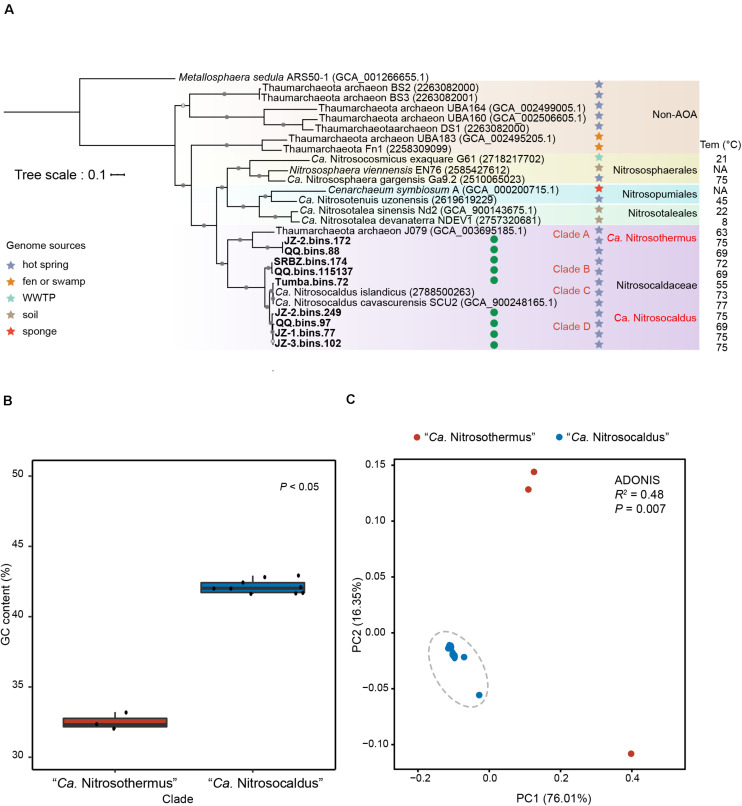
(A) Phylogenetic tree of Thaumarchaeota based on concatenation of 122 archaeal marker genes with Metallosphaera sedula ARS50-1 as outgroup (only a few genomes of other Thaumarchaeota are shown). MAGs newly obtained in this study are marked with green circles. Sources of Group HWCG-III MAGs are indicated by stars with different colors. The temperature values refer to temperature measured in the source materials. Nodes with ultrafast bootstrap value ≥95% (50%) are indicated as solid (hollow) circles, and the scale bar at the top indicates 10% sequence divergence. (B) Genome G+C content of Clade A (“Ca. Nitrosothermus”) vs. Clades B, C, and D (“Ca. Nitrosocaldus”). (C) Principal coordinates analysis (PCoA) plot based on Bray-Curtis dissimilatory of KEGG functional profiles of “Ca. Nitrosocaldaceae” MAGs, showing significantly different KEGG profiles in Clade A (“Ca. Nitrosothermus”) vs. Clades B, C, and D (“Ca. Nitrosocaldus”).